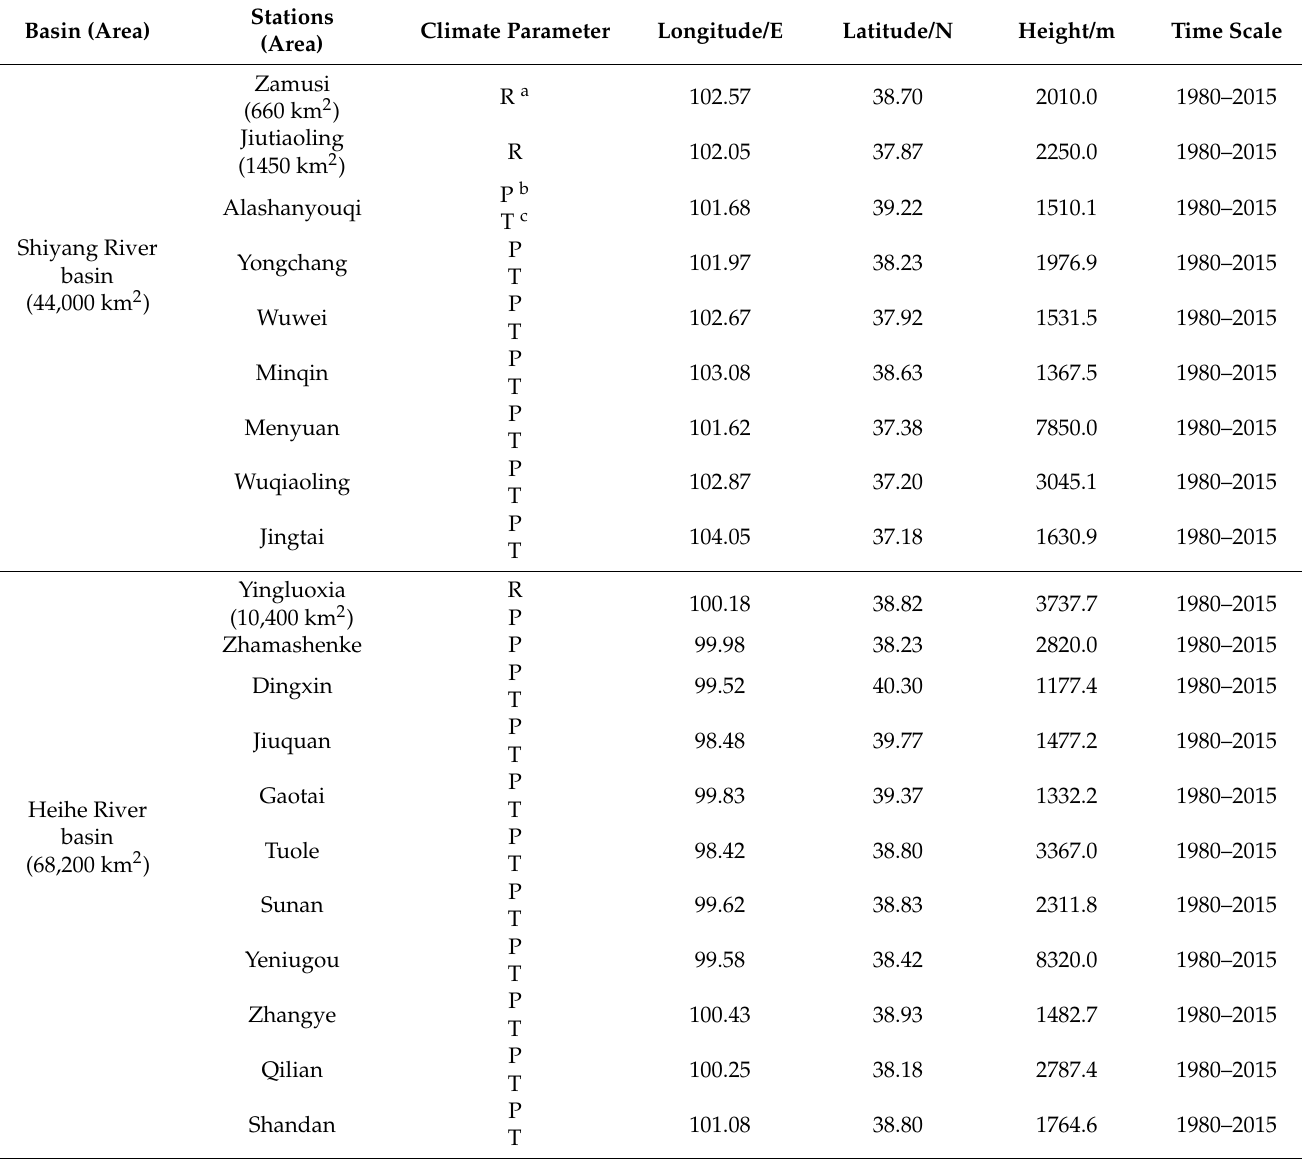
Table 1. Information on the hydrological and weather stations in the study